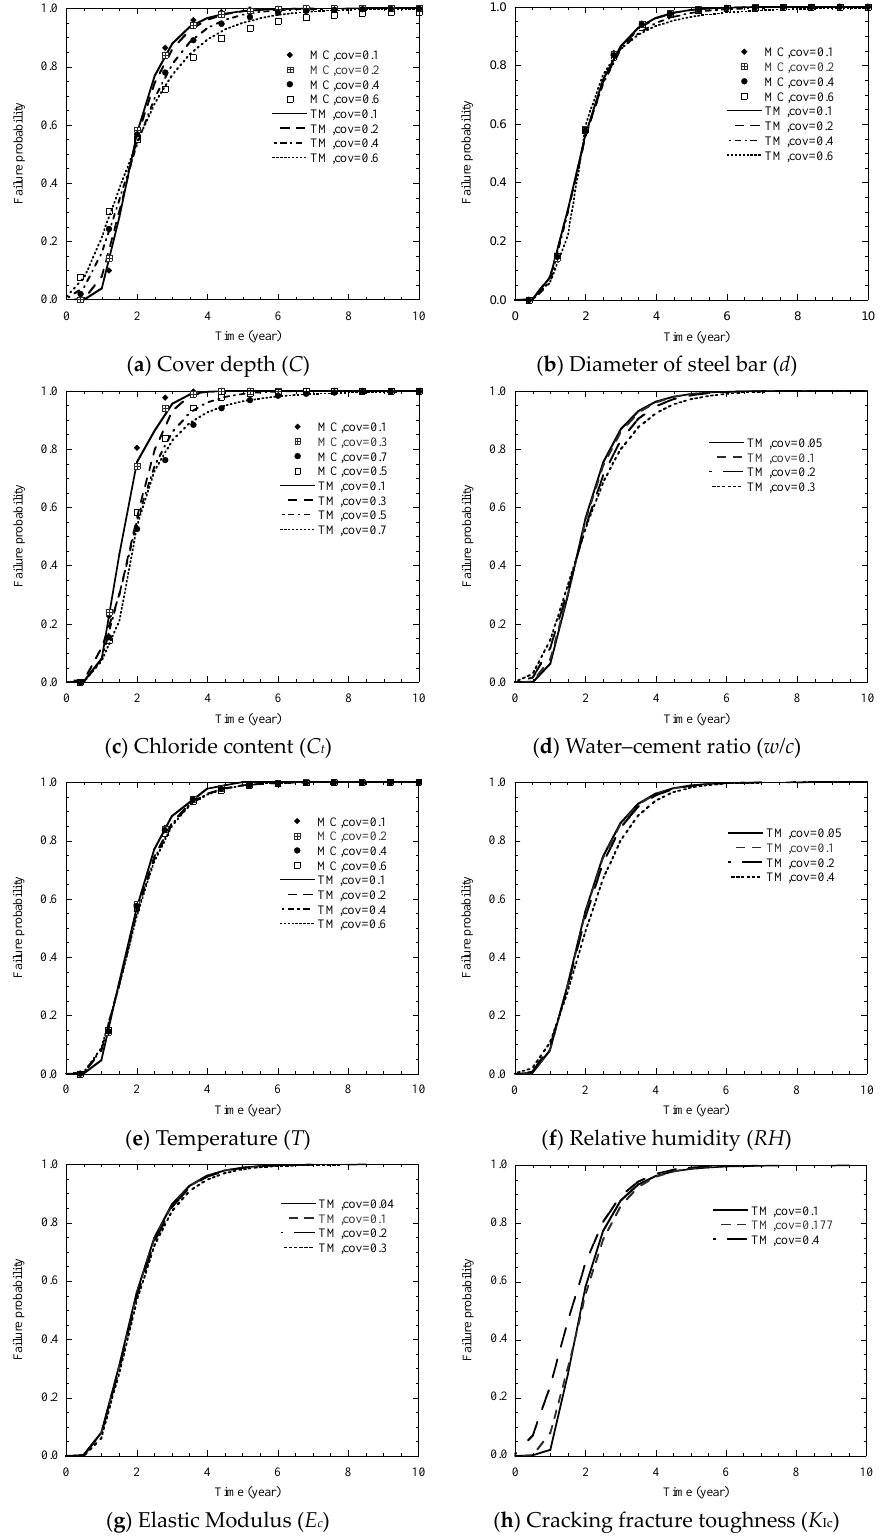
Figure 10. Influence of the coefficient of variation of different factors on failure probability of cover cracking.